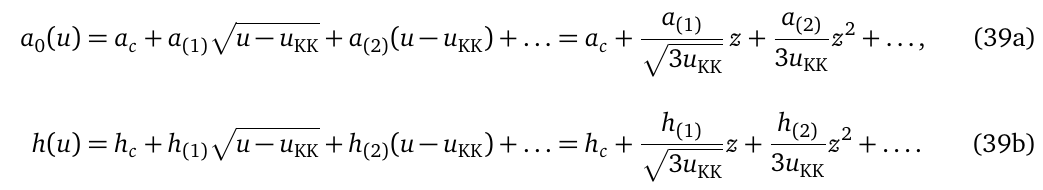
(the latter is only relevant 4